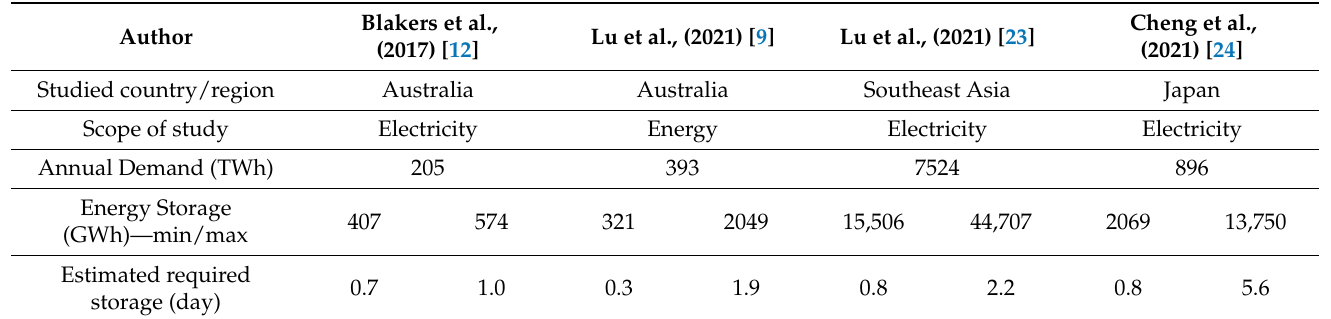
Table 2. Estimated storage requirements (days) for several regions for 100% renewable energy (primarily solar and wind with existing hydro and